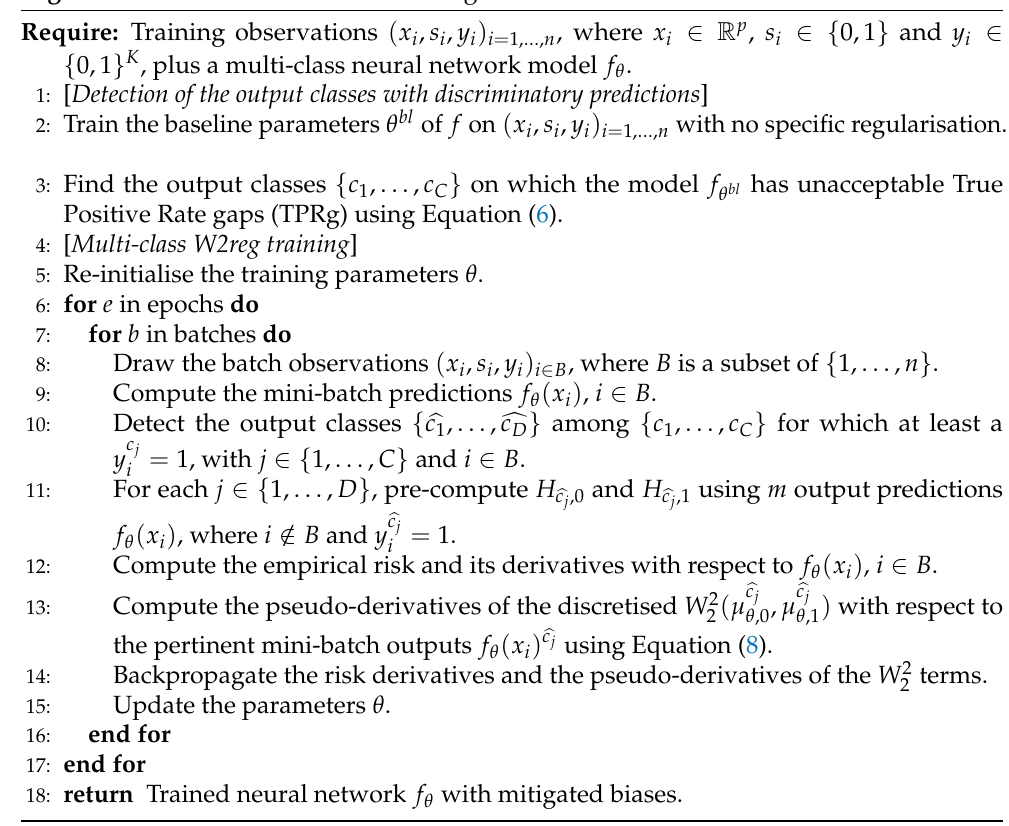
Algorithm 1 Procedure to train bias mitigation multi-class neural network